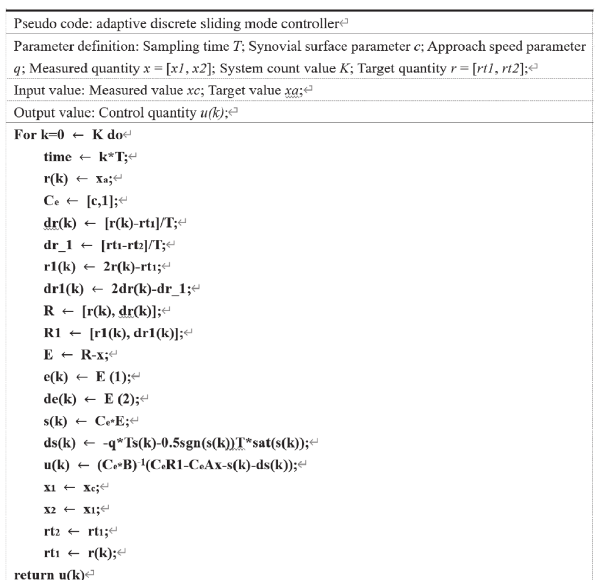
Figure 4: Pseudocode implementation of adaptive discrete sliding mode controller.